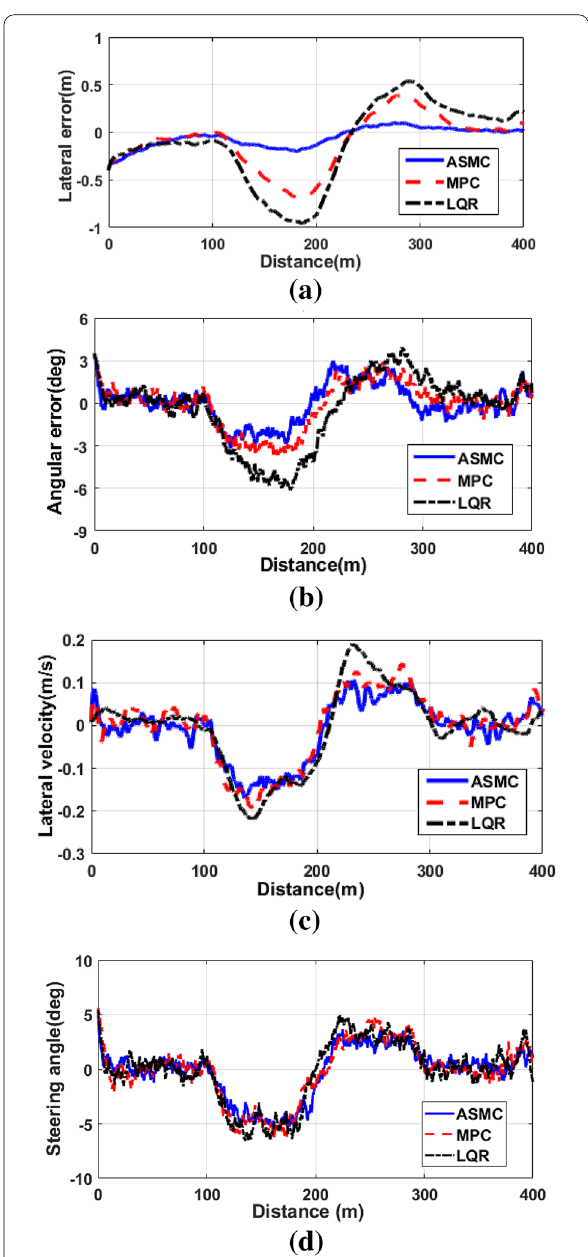
Figure 11 Response results of system states in experimental test II